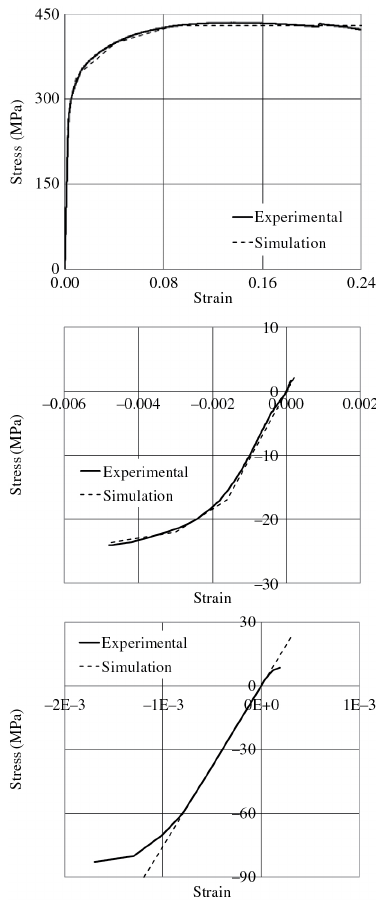
Figure 4: Simulation of the mechanical behavior of the materials of the numerical model. (A) Titanium. (B) Cement-based filling material. (C) Dionysos marble.